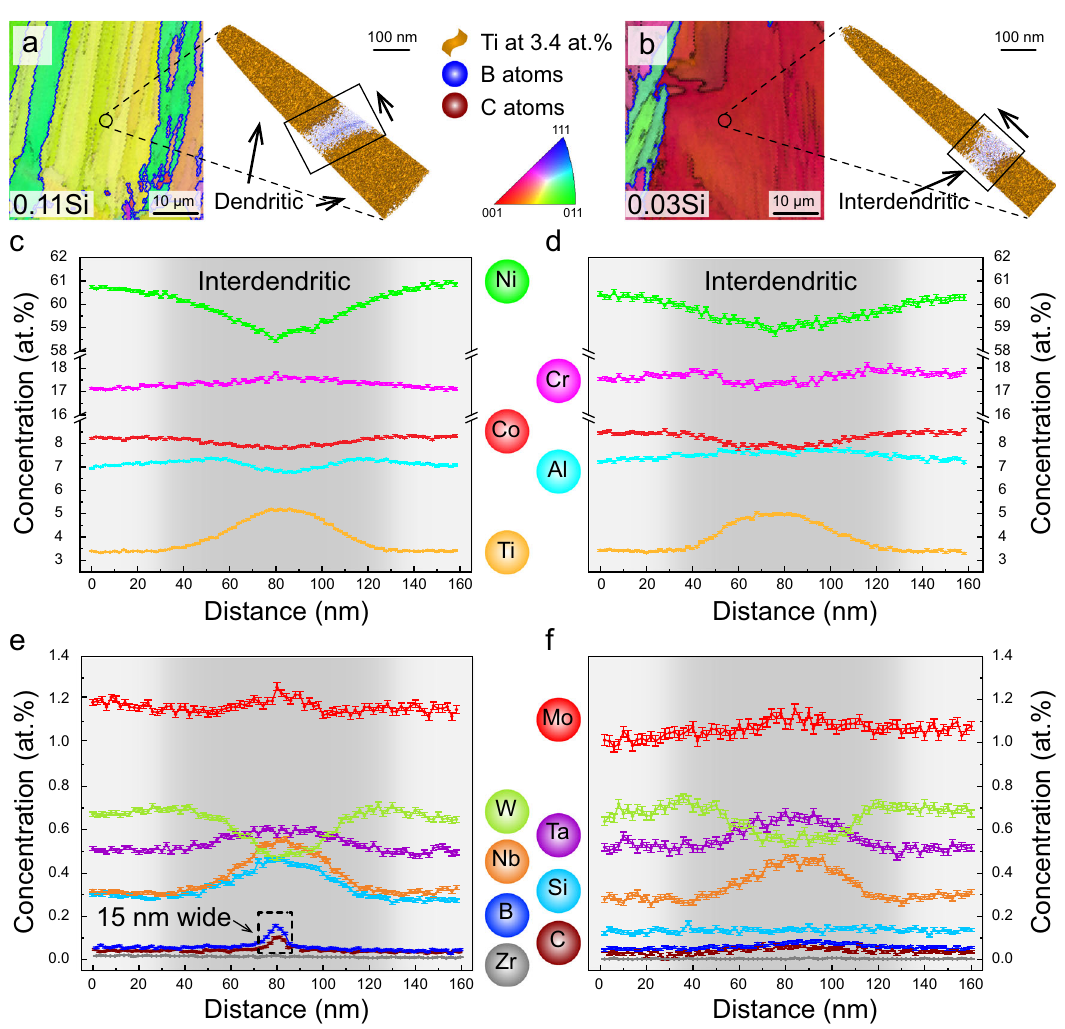
Fig. 4 | Atom probe tomography (APT) measurements of the interdendritic segregations of the 0.11Si and 0.03Si samples. a , b APT samples are extracted fromtheintragranularregionsasshownintheIPFmaps.Isosurfacesof3.4at0.%Ti were highlighted as yellow according to the dendritic concentration. The inter- dendritic regions are free of such isosurfaces. A thin layer of B and C was found in